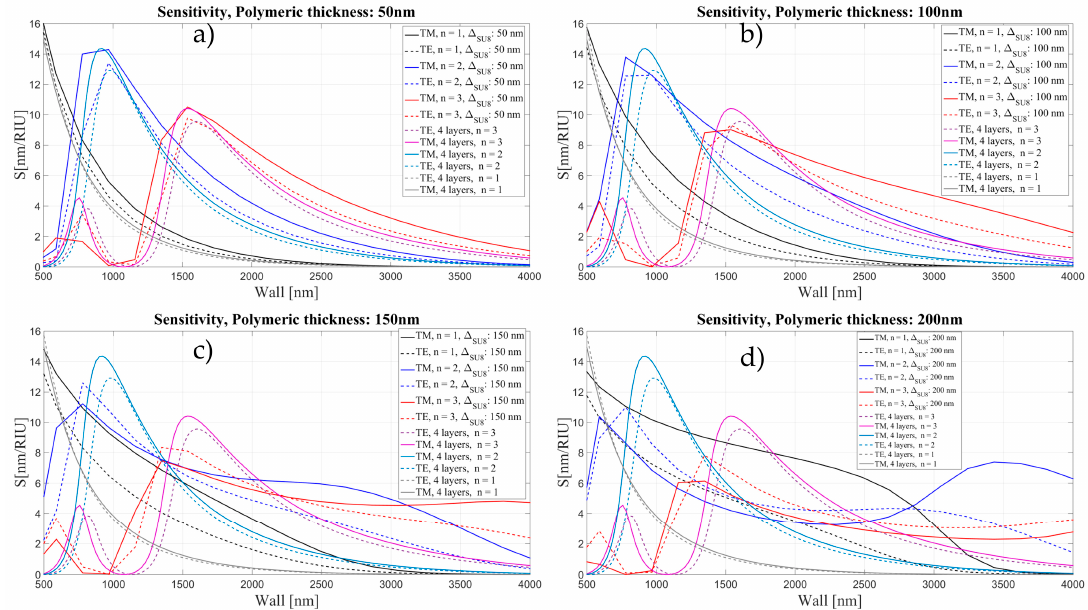
Figure 16. Sensitivity (nm/RIU) for the 4 and 5 layers model as a function of wall thickness for two different polarizations and 3 mode orders, corresponding to different thickness of polymeric layer: ( a ) 50 nm; ( b ) 100 nm; ( c ) 150 nm; and ( d ) 200 nm.